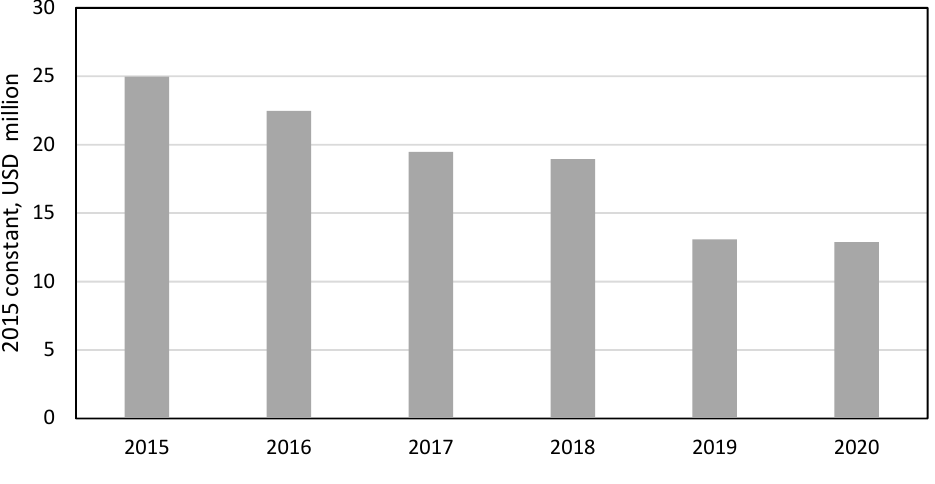
Figure 8. CRE budget allocated by the federal government.